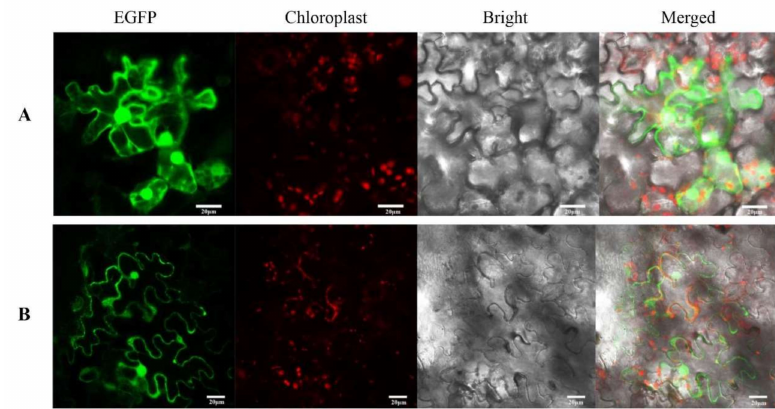
Figure 4. The subcellular localization of CnDFR. ( A ) Observation by LSM510 Meta of the EGFP empty vector. White scale: 20 µ m. The green fluorescence signals appeared in the nucleus, cell membrane and cytoplasm under the excitation of the wavelength of 488 nm. ( B ) Observation of the lower epidermal cells of Nicotiana benthamiana leaves with the CnDFR-EGFP vector. White scale: 20 µ m. The nucleus and cell membrane expressed a strong green fluorescence signal.